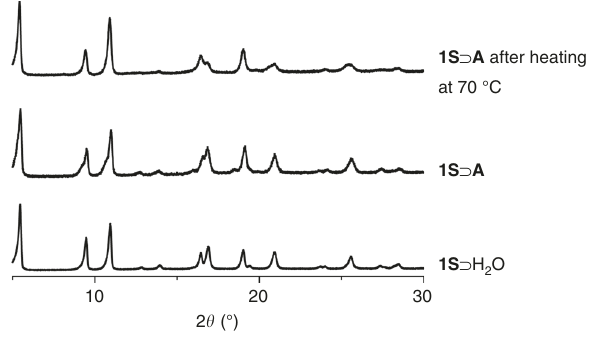
Fig. 3 XRPD patterns of 1S with guests. XRPD patterns of 1S ⊃ H 2 O, 1S ⊃ A and 1S ⊃ A after heating at 70 °C. The same diffraction patterns were observed in all the samples, showing that the crystal structure of the host was maintained during the monomer adsorption and the